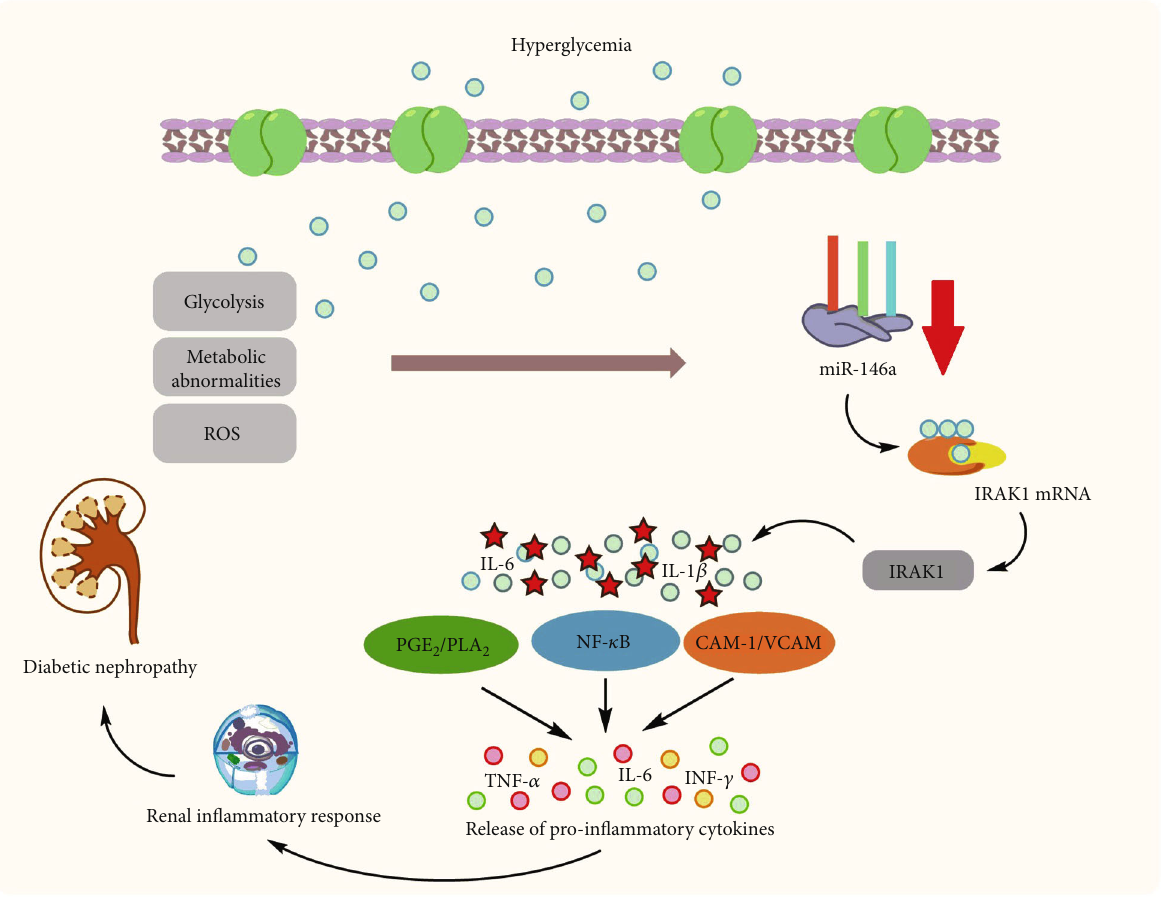
Figure 3: Association of miR-146a with diabetic